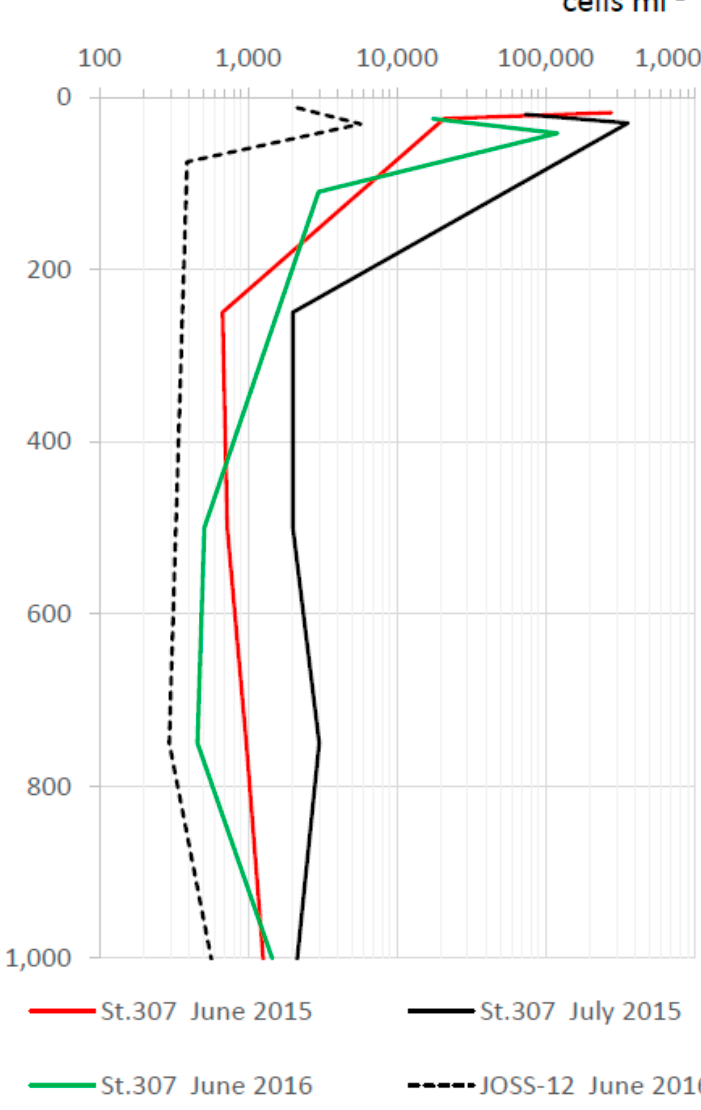
Figure 5. Vertical distribution of picocyanobacteria number in the West (St. 307) and East (JOSS-12) station of Black Sea (from [12,24], modified).